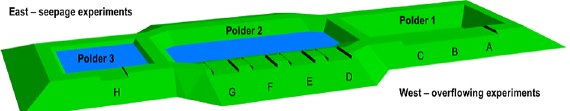
Fig. 1. Rostock research dike, West view, A–H different